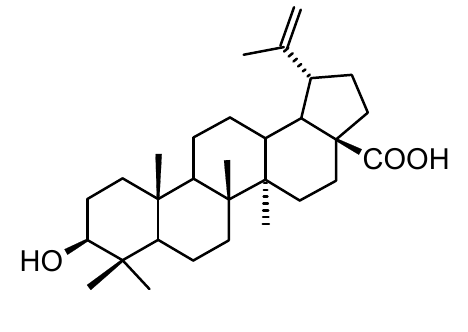
Figure 1. Betulinic acid (BA) molecular